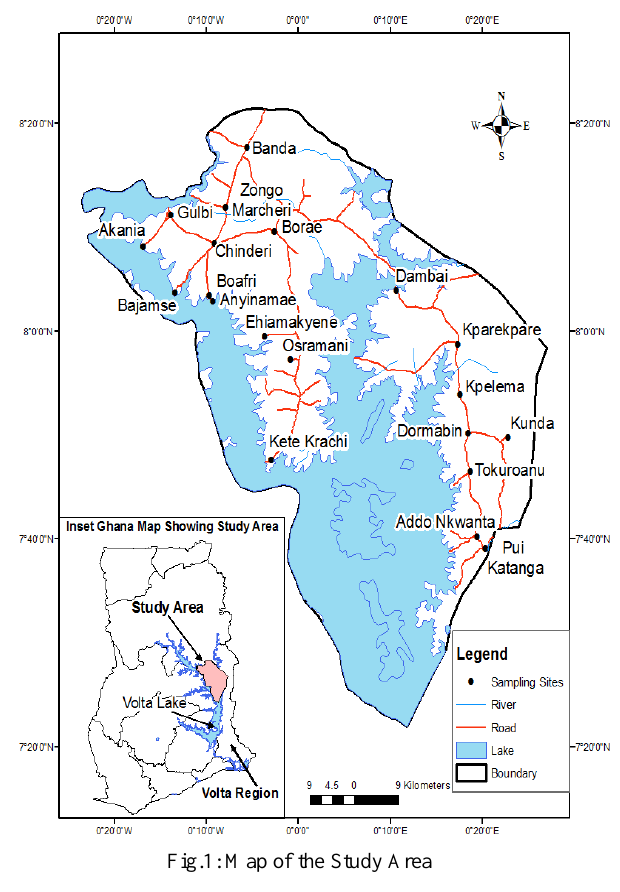
Fig.1: Map of the Study